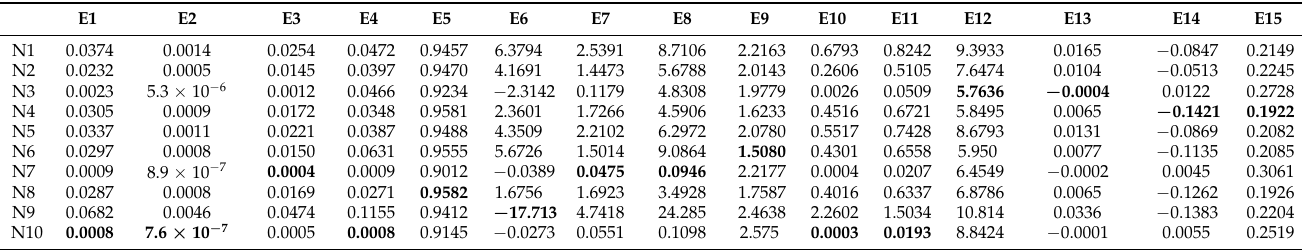
Table 9. Error values in testing Legendre network for Coinbase Pro